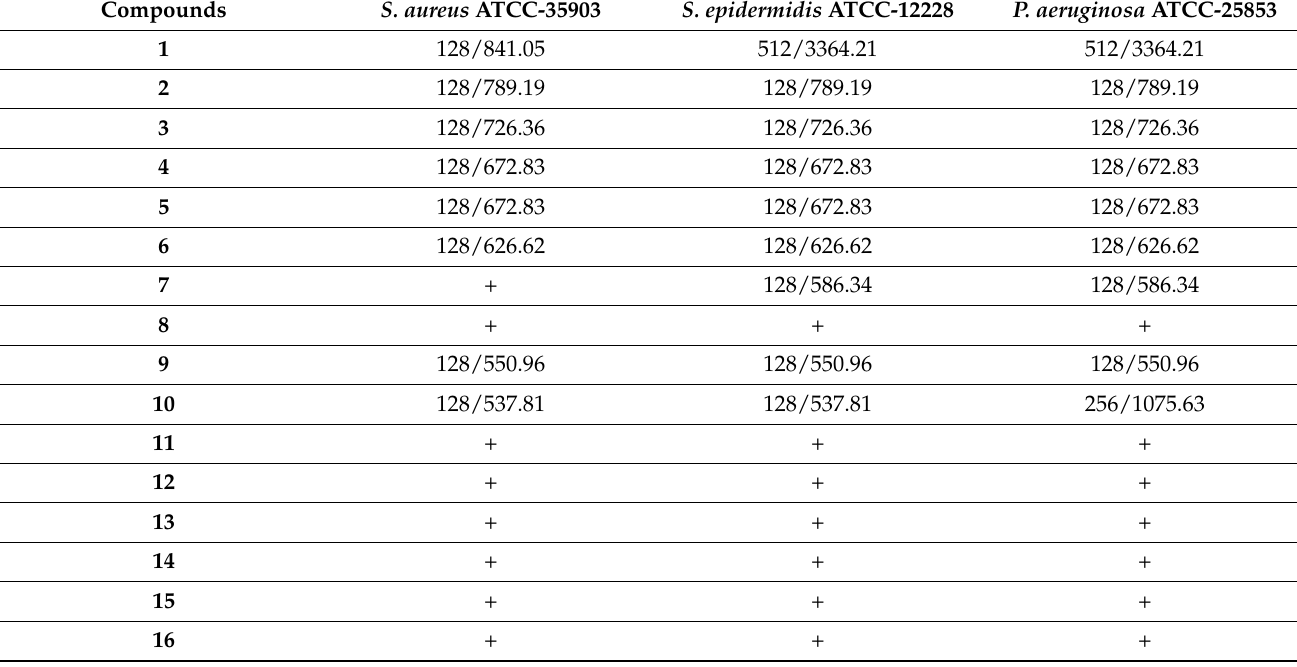
Table 6. MIC ( µ g/mL and µ M) of compounds 1 – 20 against bacterial